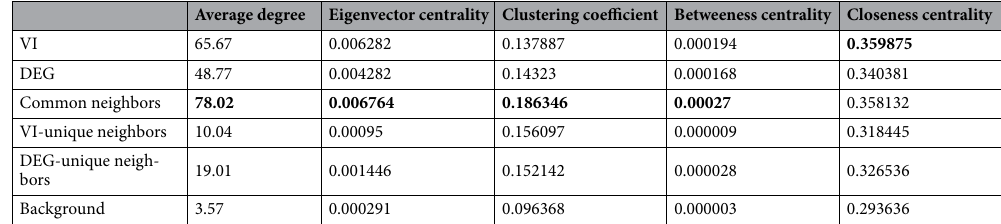
Table 1. Network properties of molecular interaction network (MIN), focusing on the following gene sets: viral interactors (VI), differentially expressed genes after infection (DEG), overlap of the direct network neighbors in the MIN of these two sets (common neighbors), neighbors of the VI and DEG gene set that were not in the common neighbor genes set (VI-unique neighbors and DEG-unique neighbors), and the rest of the genes in the MIN (background genes). The common neighbor gene set exceeds the other genes sets in all of the measures except for closeness centrality, in which VI gene set has the highest value (the highest value for each measure is highlighted in